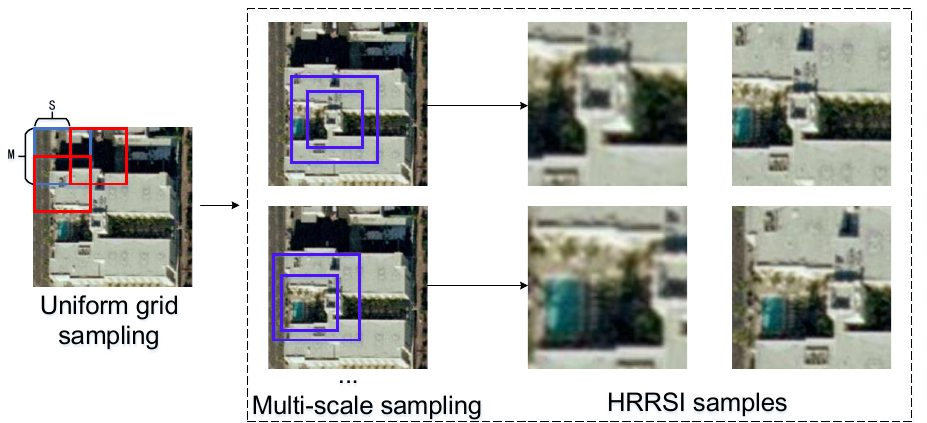
Figure 5. The method of multi-scale grid